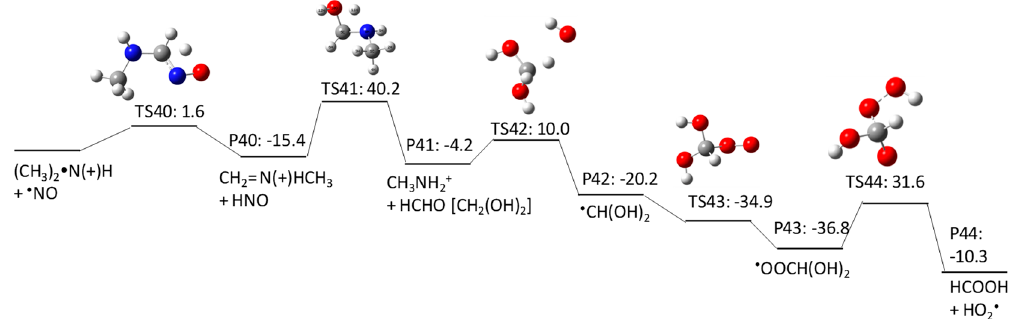
Figure 12. Free energy profile for pathway 4–1 of the HO • -induced reaction pathways for NDMA photolysis.